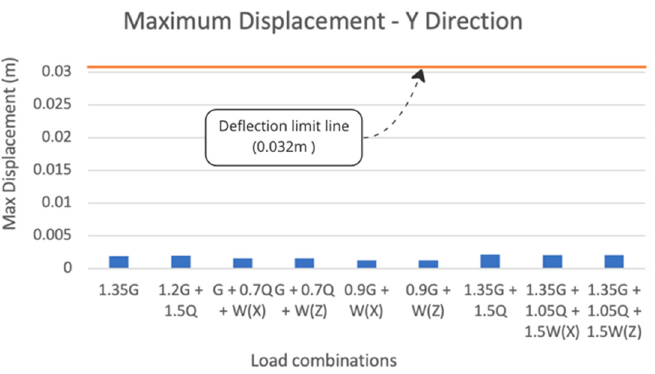
Figure 22. Deflection limit and the maximum vertical deflection for each load combination for DFF.